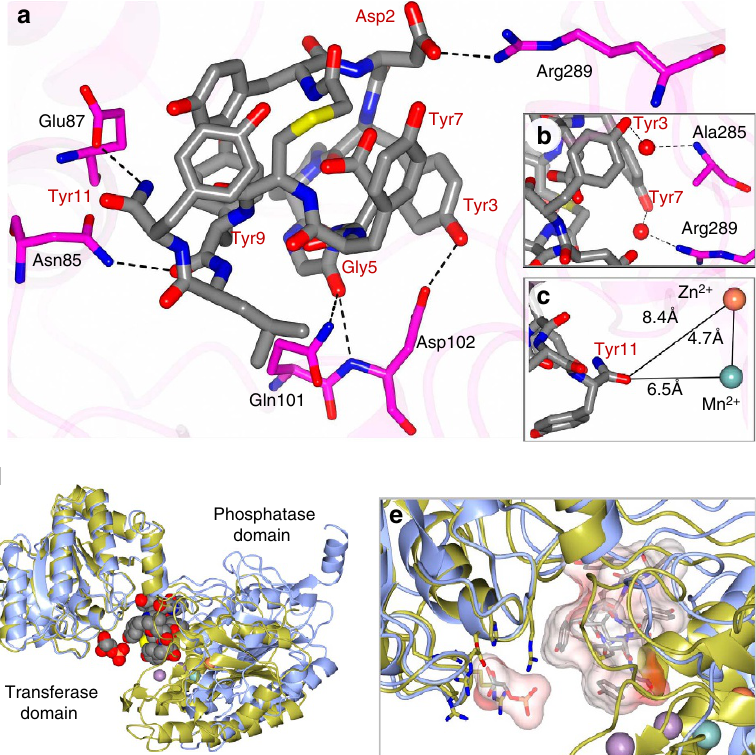
Figure 4 | Ce-2d (cid:3) iPGM interactions. ( a ) Hydrogen bond interactions (black dashed lines) between C. elegans iPGM and Ce-2d . Direct interactions and ( b ) water (red spheres) mediated contacts. ( c ) Distance from the C-terminal amide of Tyr11 and the Zn 2 þ and Mn 2 þ ion centres. ( d ) Superimposed structure of C. elegans iPGM (cid:3) Ce-2d with that of Staphylococcus aureus iPGM in 2-phosphoglyceric acid bound form (PDB: 4NWX). The following, S. Aureus : C. elegans residue pairs were used for alignment: 123His147, 153-154Asp177-178, 191Arg216, 185Arg210, 257Arg284 and 260Arg287. Ce-2d and 2-PG are shown as CPK space filling models. The purple spheres are the Mn 2 þ ions of S. aureus iPGM and the blue and tan spheres are the Mn 2 þ and Zn 2 þ ion, respectively of C. elegans iPGM. ( e ) Enlarged region from d showing the relative locations of the 2-PG and Ce-2d as cylinder models with transparent van der Waals surfaces and alignment residue side chains clustering around